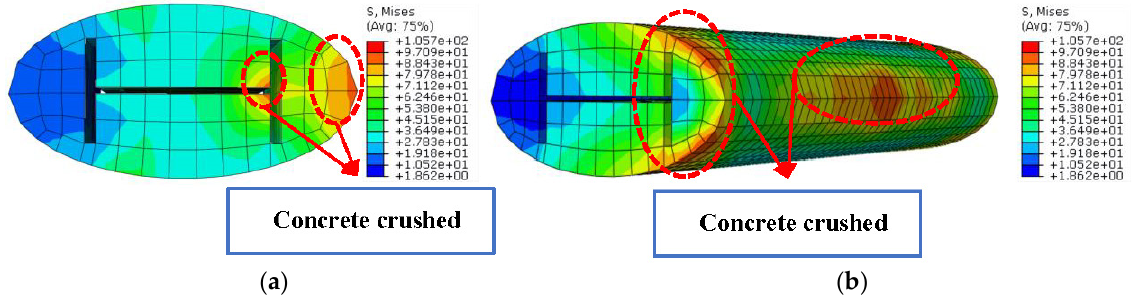
Figure 20. Concrete failure diagram for the finite element simulation of typical specimen HUCFEST-18: ( a ) crushed concrete on the inner side of the H-shape steel in the span section; ( b ) concrete of the compression area was crushed.